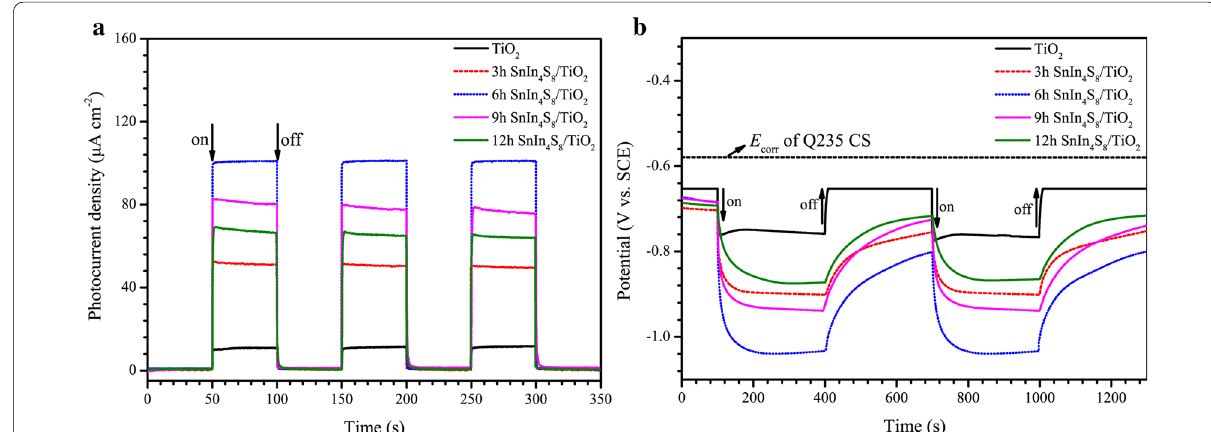
Fig. 7 Variations in the a photocurrent density and b potential of the Q235 CS electrode coupled to the prepared TiO 2 and different SnIn 4 S 8 /TiO 2 photoanodes under intermittent visible light